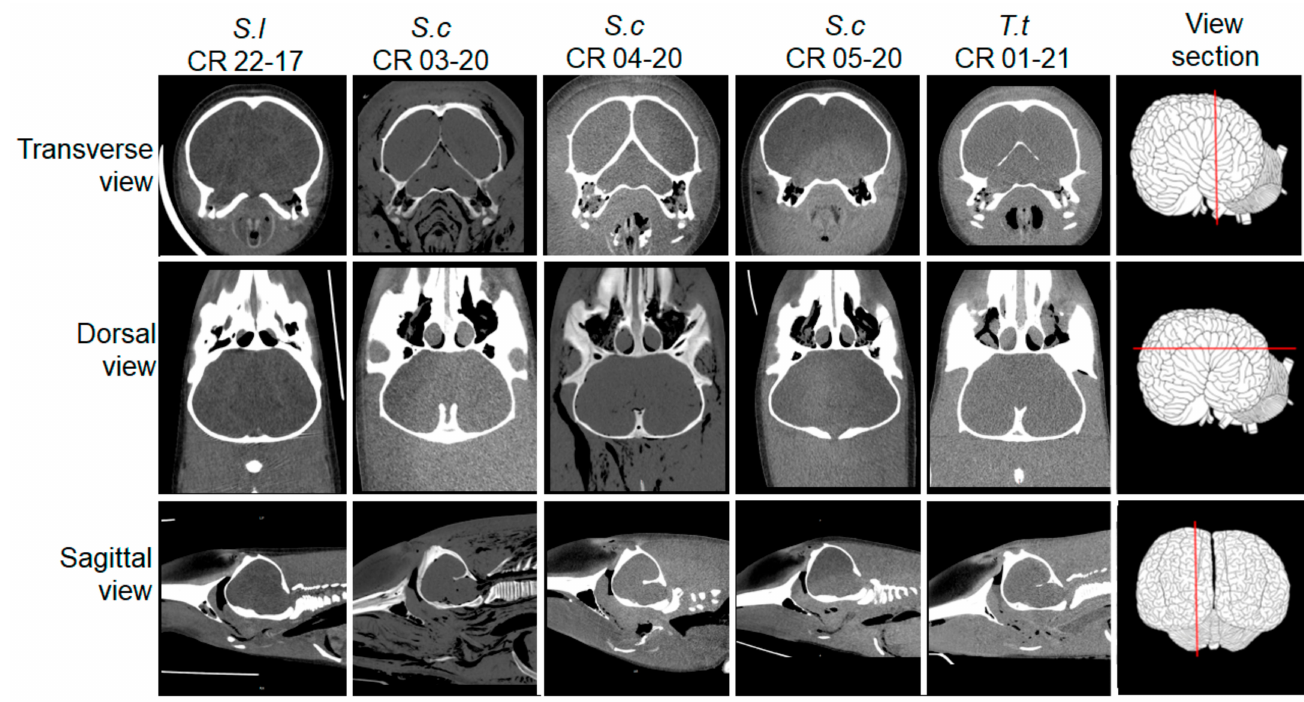
Figure 1. Reconstruction by PMCT of transverse, dorsal, and sagittal virtual brain sections of adult dolphins with no signs of CNS alterations. The red line crossing the brain scheme depicted at the far right of the figure indicates the plane of the virtual computed tomography section. S.l , S. longirostris ; S.c , S. coeruleoalba ; T.t , T. truncatus